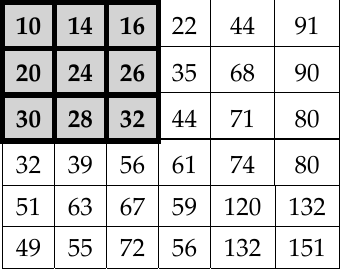
Figure 6. Numerical representation of an image.